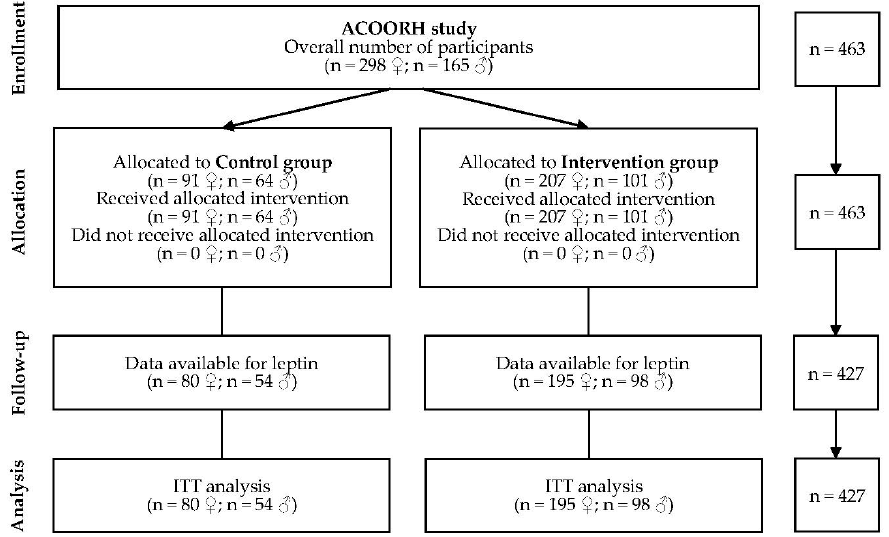
Figure 1. Flow chart. ITT: intention-to-treat Baseline characteristics (Table 1) did not differ significantly between the control and intervention group. In participants with prediabetes serum leptin levels tended to be